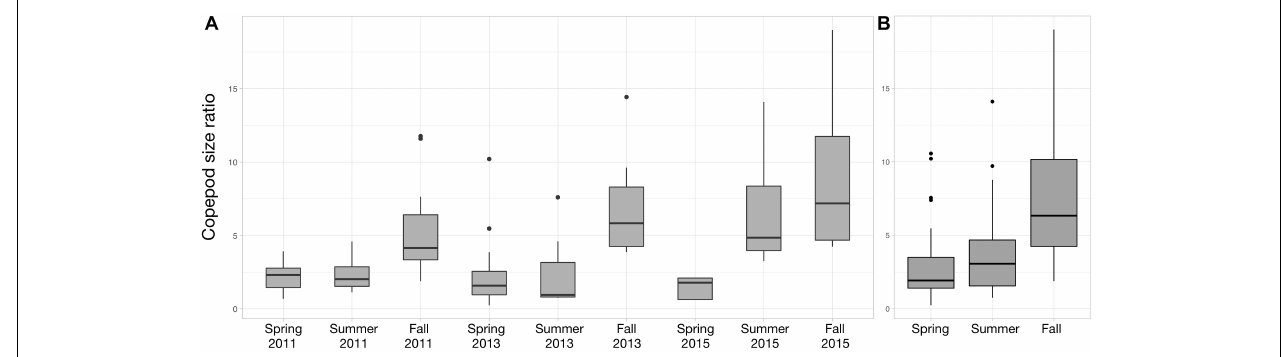
FIGURE 7 | Distribution of the copepod size ratio (small/large) between Spring 2011 and Fall 2015 (A) and between the three seasons (B) . Copepod size ratios were computed from the abundances of small ( < 1 mm) and large ( > 1 mm) copepods. Data from Spring 2012 were not showed to facilitate the visualization of the seasonal variations (no samples in Summer and Fall 2012), but they were used to compute the variations across the three seasons studied (B)